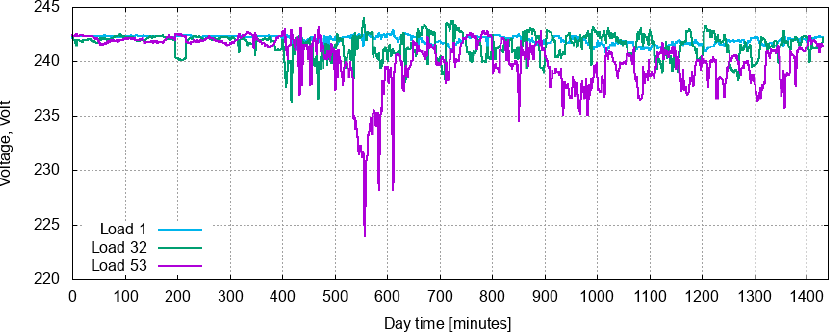
Figure 3. Attack scenario 1—Voltage levels under attack.